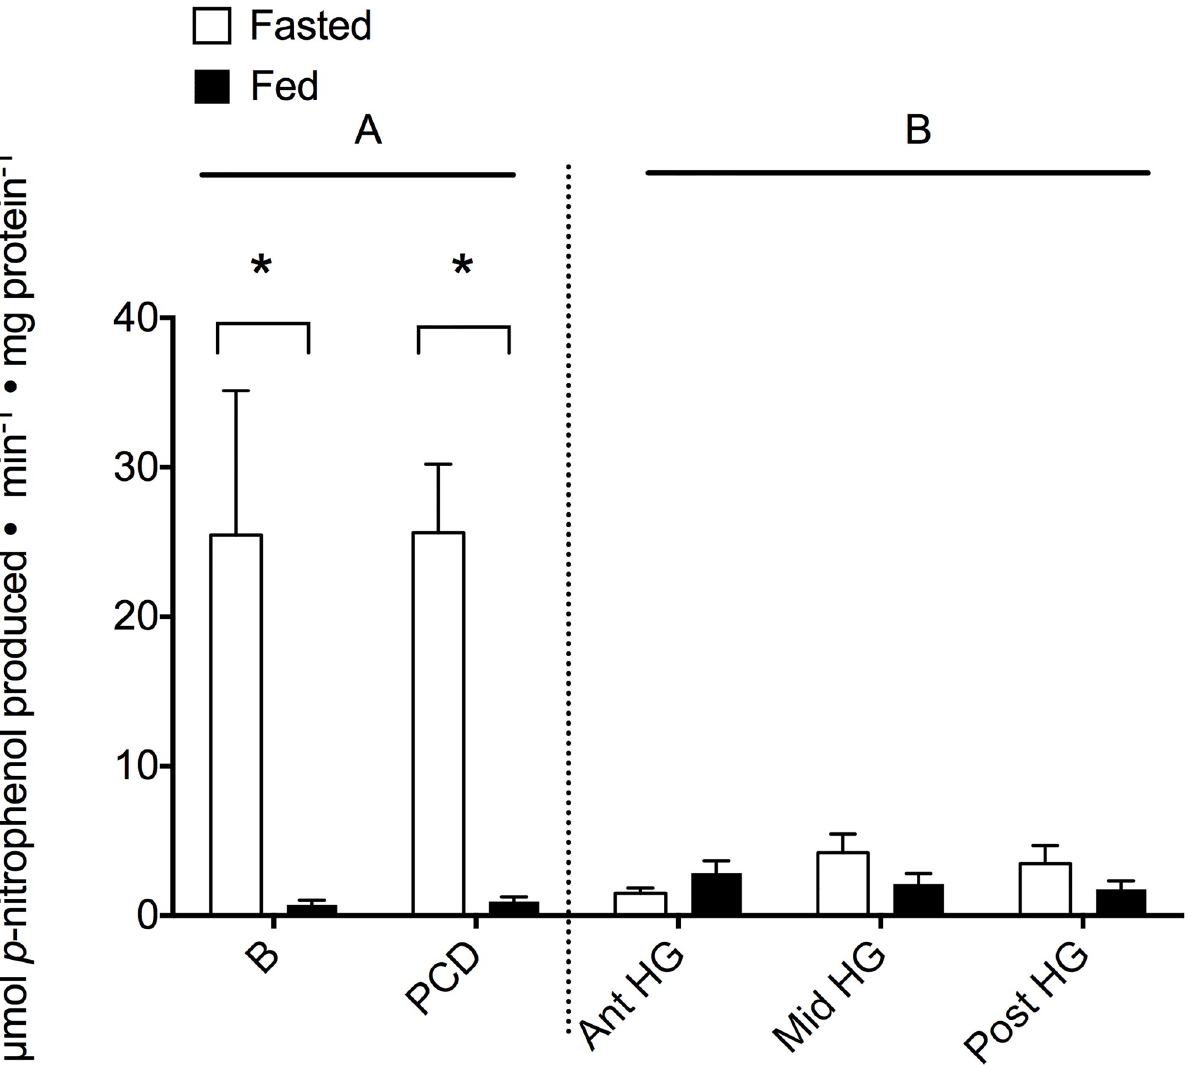
Fig 3. Lipase activity ( μ mol p -nitrophenol min -1 mg protein -1 ) is dependent upon location within the alimentary canal and significantly decreases post-feeding in the anterior segment. Activity was measured in both fasted (white bars) and fed (black bars) hagfish in five locations down the alimentary canal (B—buccal cavity, PCD—pharyngocutaneous duct, Ant HG—anterior hindgut, Mid HG—mid hindgut, Post HG—posterior hindgut). Bars represent means + s.e.m. of 5–11 hagfish. Letters denote significant differences between locations as determined by a Kruskal-Wallis ( α = 0.05) comparing anterior vs . posterior segments (separated by the dotted line), whereas asterisks ( � ) denote difference in feeding state as determined using a Mann Whitney Rank Sum Test ( α = 0.05) within a segment.